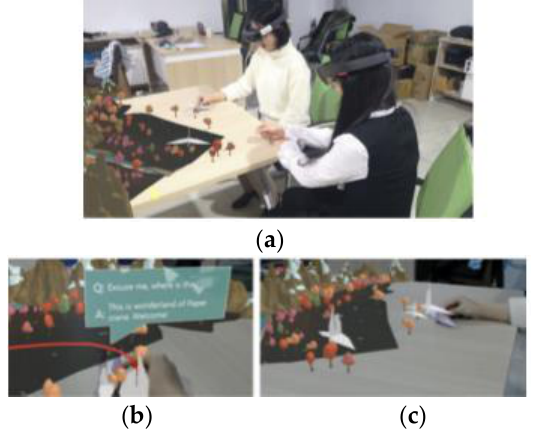
Figure 38. Storytelling model with two users view the story ( a ), story-teller’s views ( b ), the audience’s views ( c ) [70].